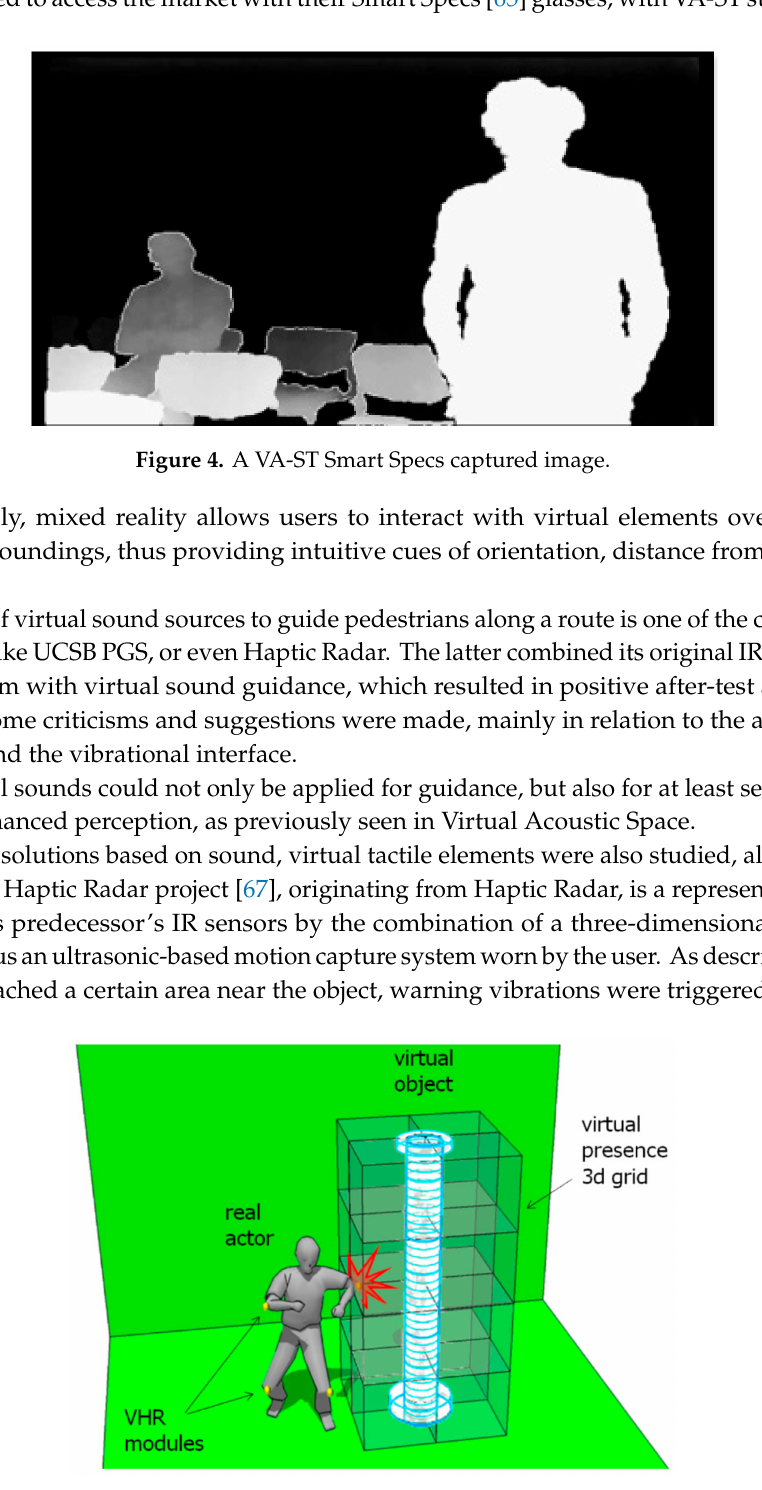
Figure 5. Virtual Haptic Radar